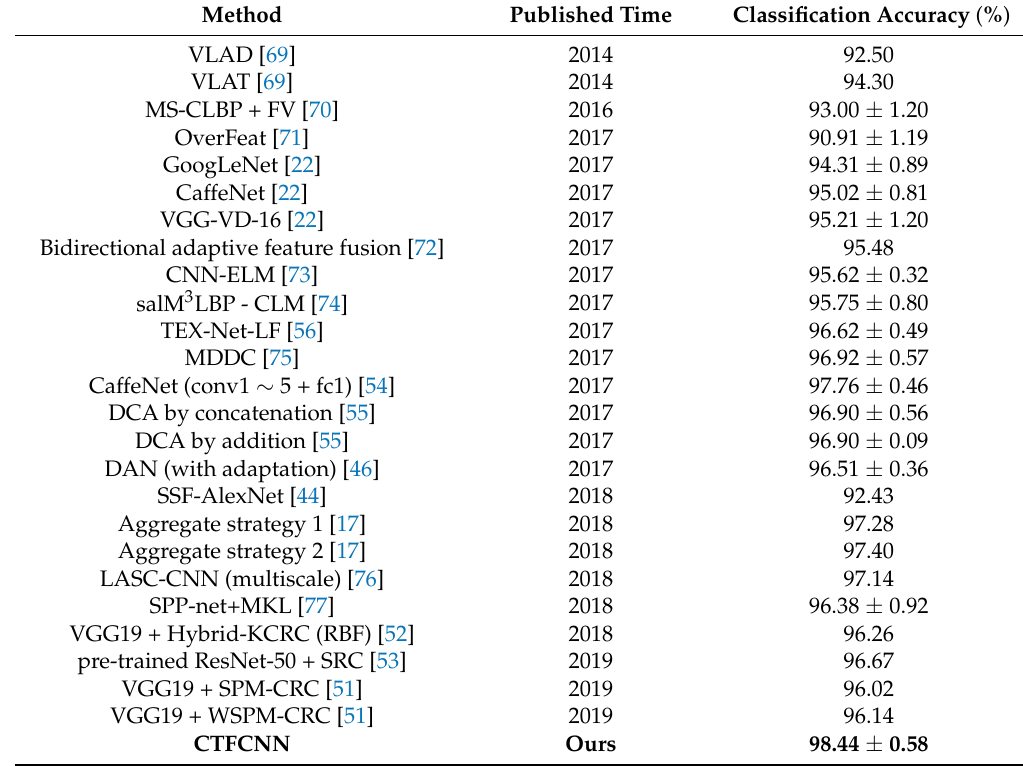
Table 2. Overall accuracy (mean ± SD) comparison of recent methods under the training ratio of 80% on the UC-Merced